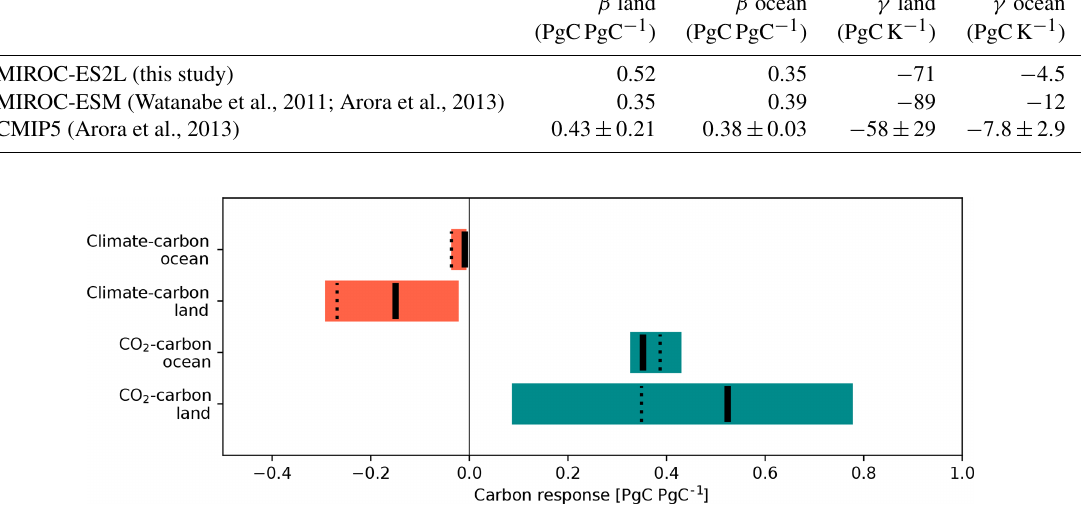
Table 6. Comparison of CO 2 –carbon and climate–carbon feedback parameters between MIROC-ES2L, MIROC-ESM, and the CMIP5 ESMs. As presented in Arora et al. (2013), TCR, AF, and TCRE are calculated at the time when the CO 2 concentration is quadrupled from the preindustrial condition (i.e., the 140th year in the 1PPY simulation) by taking the anomaly from the CTL run. Numbers for CMIP5 ESMs were obtained from Arora et al. (2013) and are presented as the multimodel mean ± 1 σ . β land β ocean